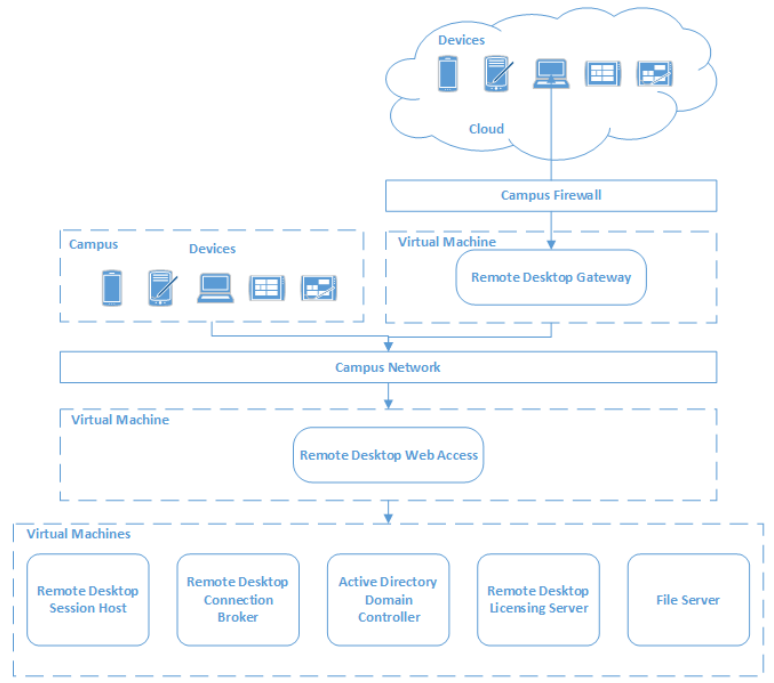
Figure 2. System architecture.